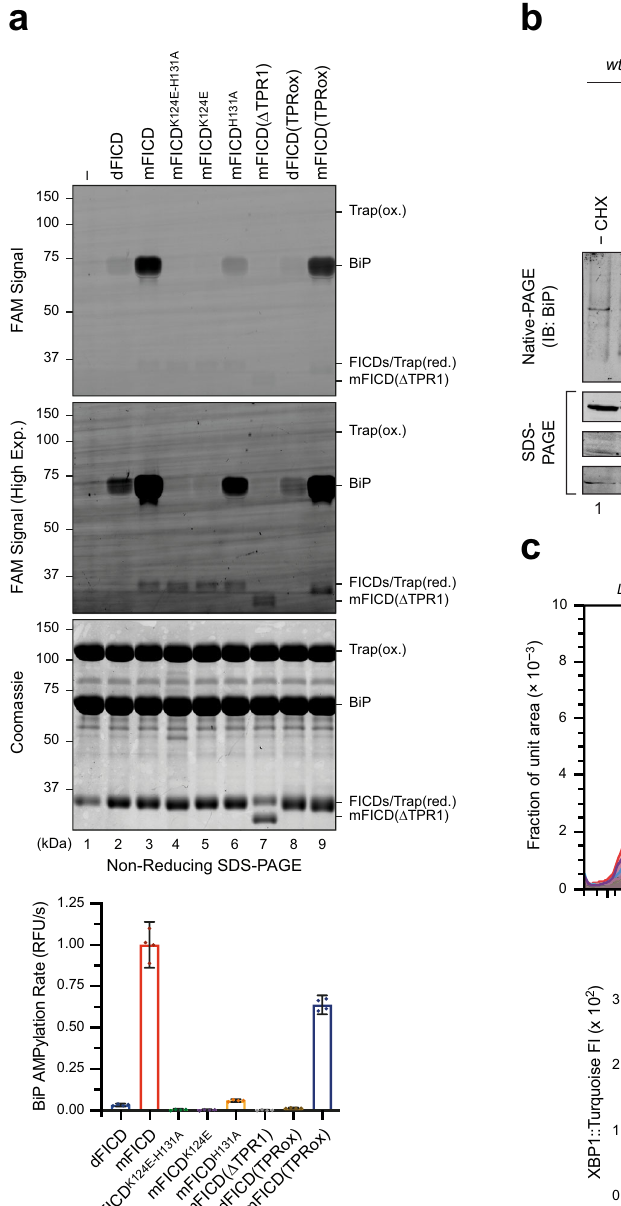
0.000.250.500.751.001.25 Fig. 5 FICD ’ s TPR domain is essential for AMPylation of ATP-bound BiP. a Fluorescence and Coomassie gel-images of an in vitro AMPylation assay, utilising ATP(FAM) as the AMPylation co-substrate, in the presence of excess product trap (Trap(ox), to discourage BiP-AMP(FAM) deAMPylation 10 ). dFICD, dimeric FICD; mFICD, monomeric FICD L258D . Gels from a representative experiment are shown with the initial rates (mean ± 95% con fi dence interval (CI)) of BiP-AMPylation (in relative fl uorescent units/s), normalised to the rate of mFICD-mediated BiP-AMPylation, from n = 4 independent experiments. Note, the lack of correlation between FICD ( cis )auto-AMPylation and BiP substrate AMPylation. See Supplementary Fig. 6c. b Native-PAGE immunoblot analysis of the accumulation of AMPylated (B-form) BiP in CHO cells lacking endogenous FICD transfected with FICD variants, as indicated. Major, non-AMPylated BiP species (A, II and III) are noted. Right, quanti fi cation of AMPylated B-form BiP from n = 3 independent experiments (mean ± SD). c Histograms of the FACS signal of an XBP1::Turquoise UPR reporter in FICD − / − CHO cells expressing the indicated FICD derivatives. Note the bimodal distribution of the fl uorescent signal in FICD-transfected cells. Quanti fi cation of the fraction of cells that are stressed, as well as the median FACS signal of the low and high stressed cell populations are shown from n = 4 independent experiments (mean values ± SD). Bars and datapoints are (colour-) coded according to the histogram legend. Source data are provided as a Source Data fi